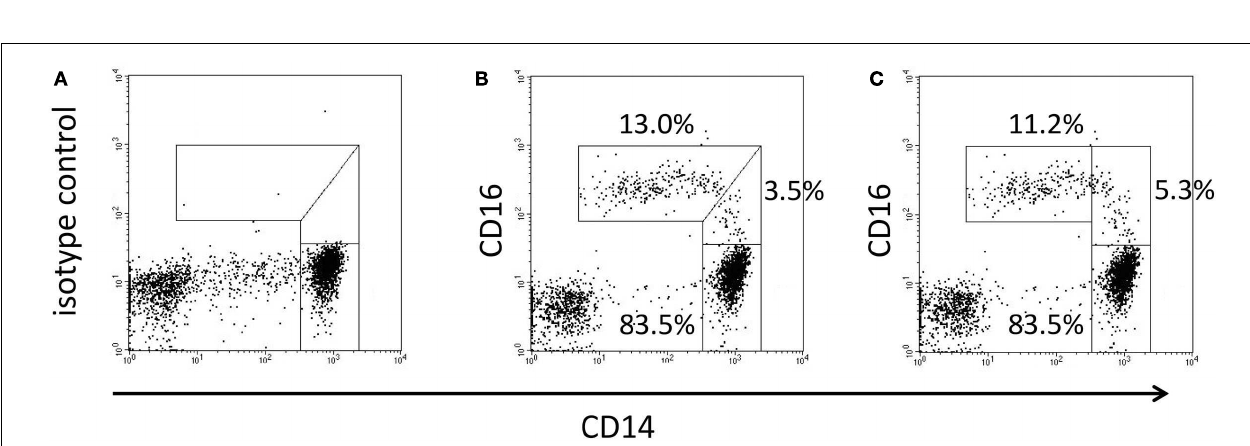
FIGURE 2 | Dissection of intermediates from classical and non-classical monocytes. In (A) the isotype control defines the separating line between intermediates and classical monocytes. In (B) the dissection of intermediate